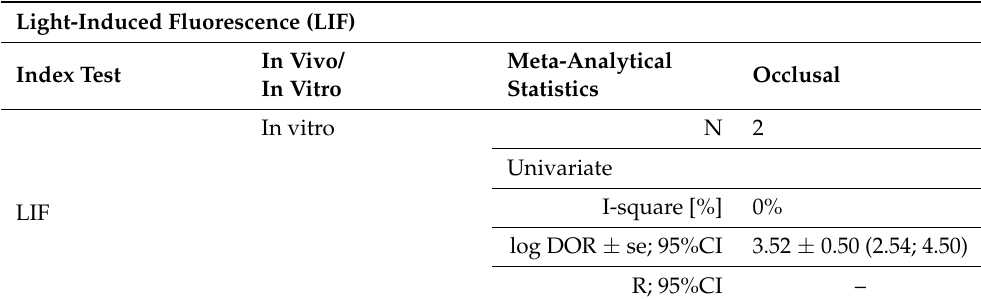
Table 10. Meta-analytical results for the LIF test. Only partial univariate statistics could be determined, due to the limited number of studies.